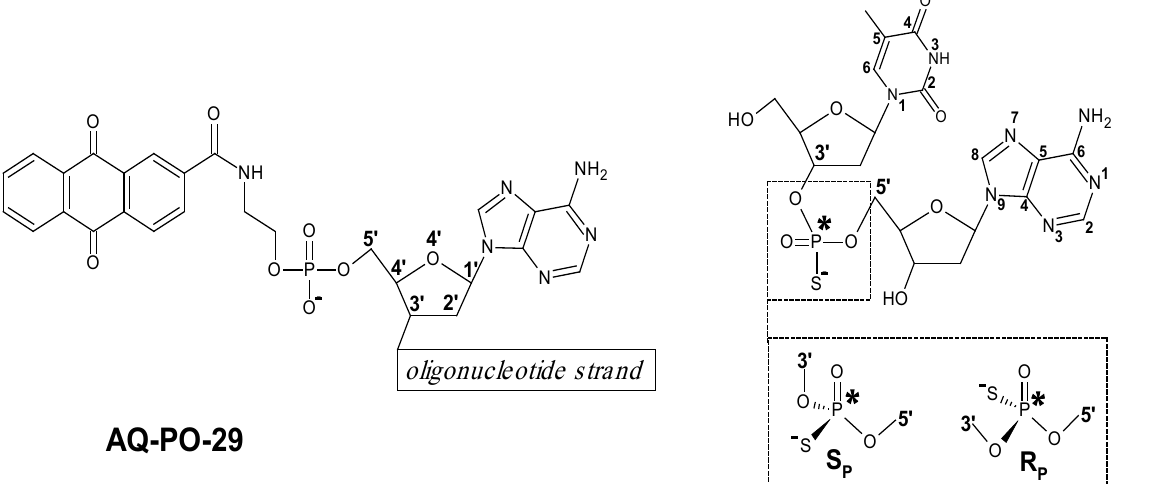
Figure 3: Graphical representation of phosphorothioate internucleotide bond stereochemistry and anthraquinone (AQ) covalent linkage to 5’-end of the oligonucleotide